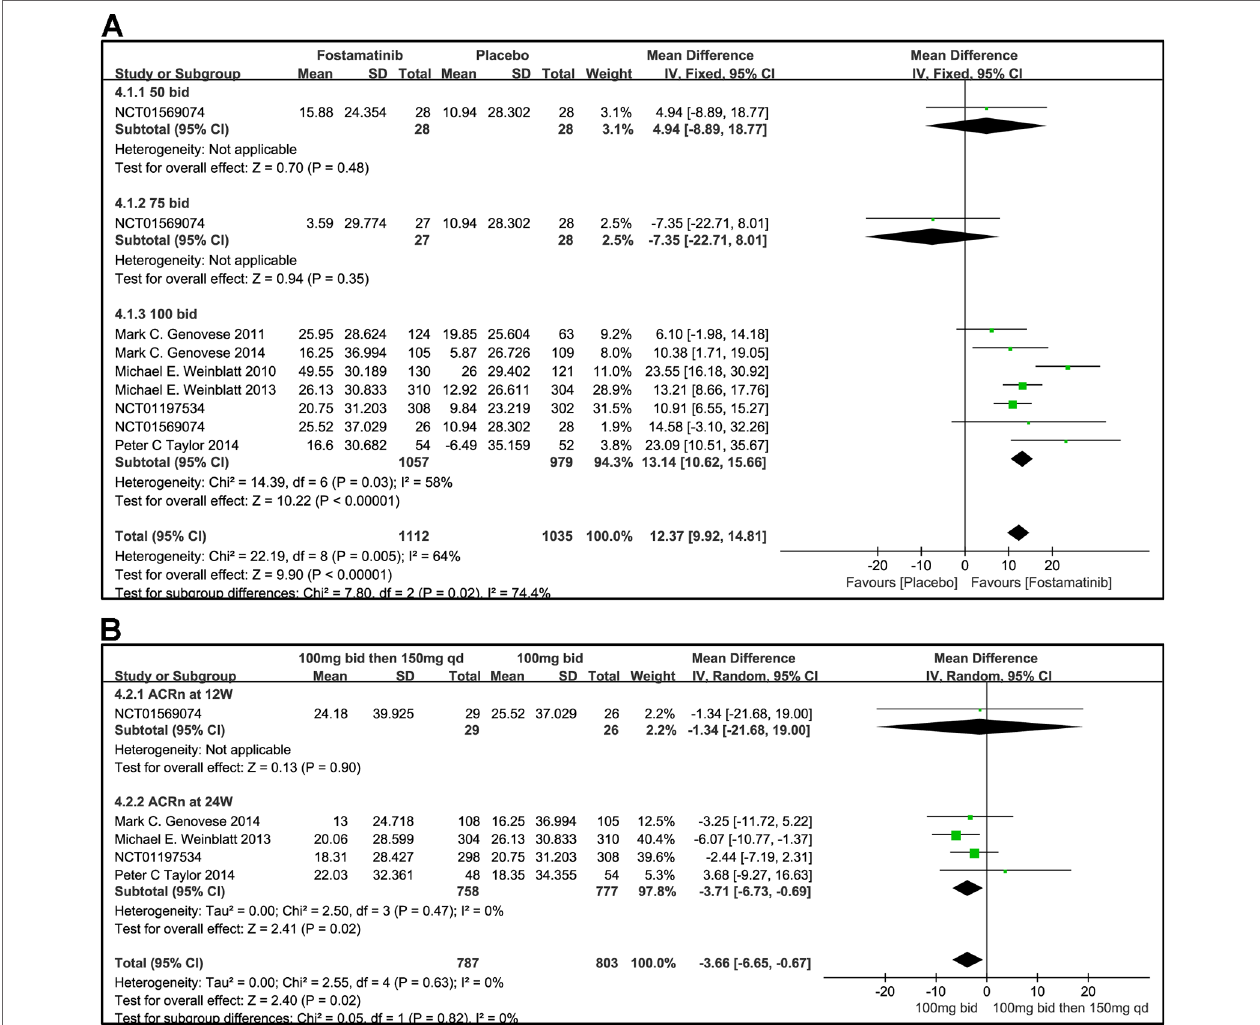
FIGURE 6 | Forest plots for the effect of multiple doses on ACRn at different time points. (A) Subgroups administered multiple doses (50, 75, and 100 mg bid) of fostamatinib vs. placebo at 24 weeks from baseline; (B) 100 mg bid for 4 weeks followed by 150 mg bid vs. 100 mg bid at 12 and 24